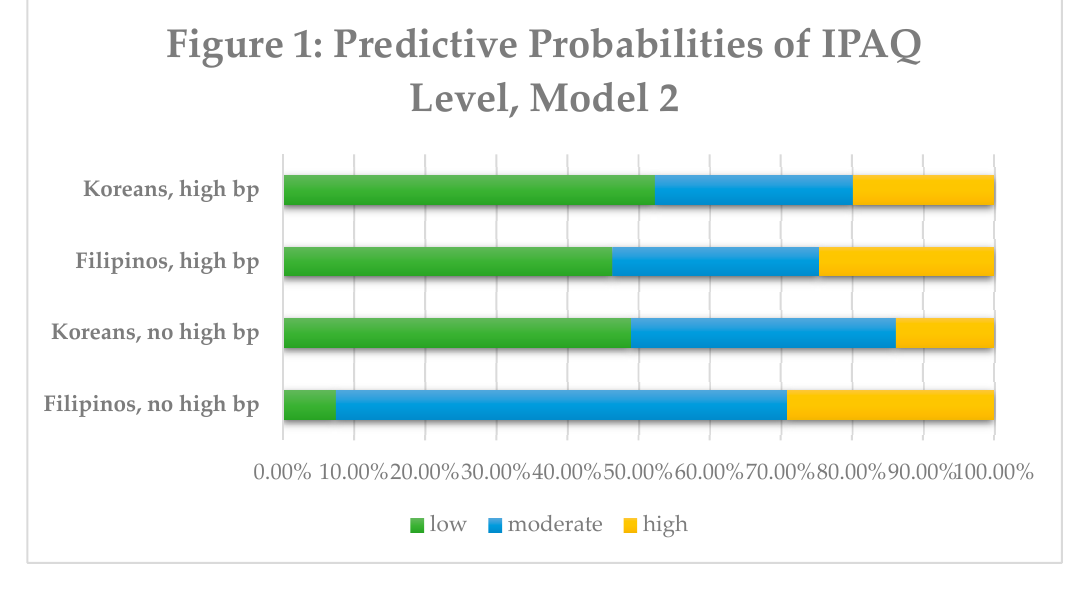
Figure 1: Predictive Probabilities of IPAQ